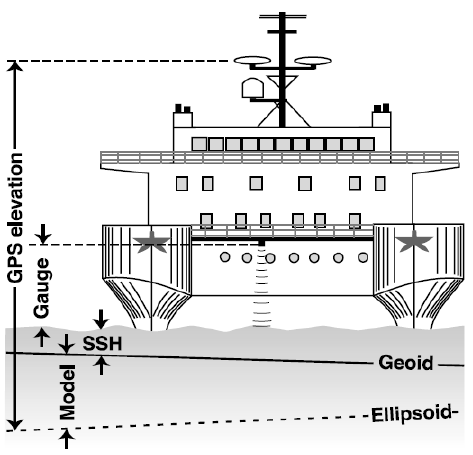
Figure 6. Schematic showing relationship between vertical measurement reference levels and cor- rections